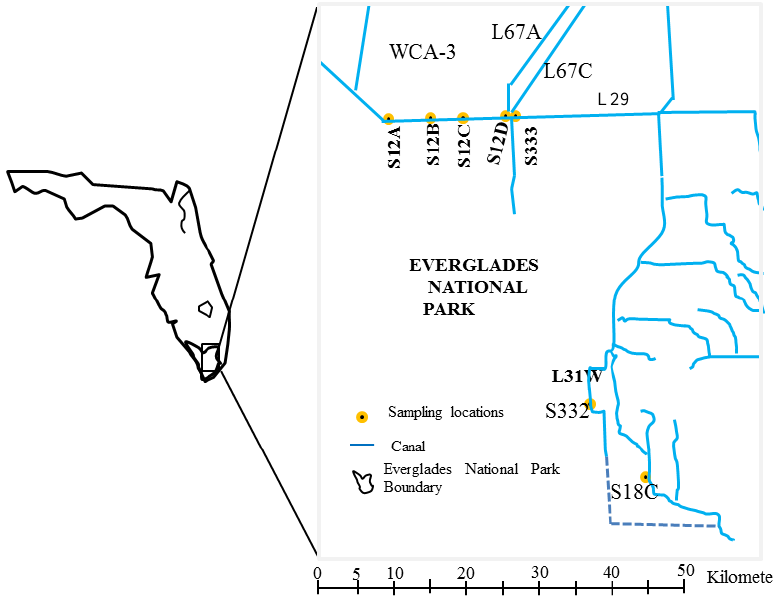
Figure 1. Location of inflow water quality monitoring stations to the Everglades National Park. Table 1. Analytical methods for selected water quality parameters